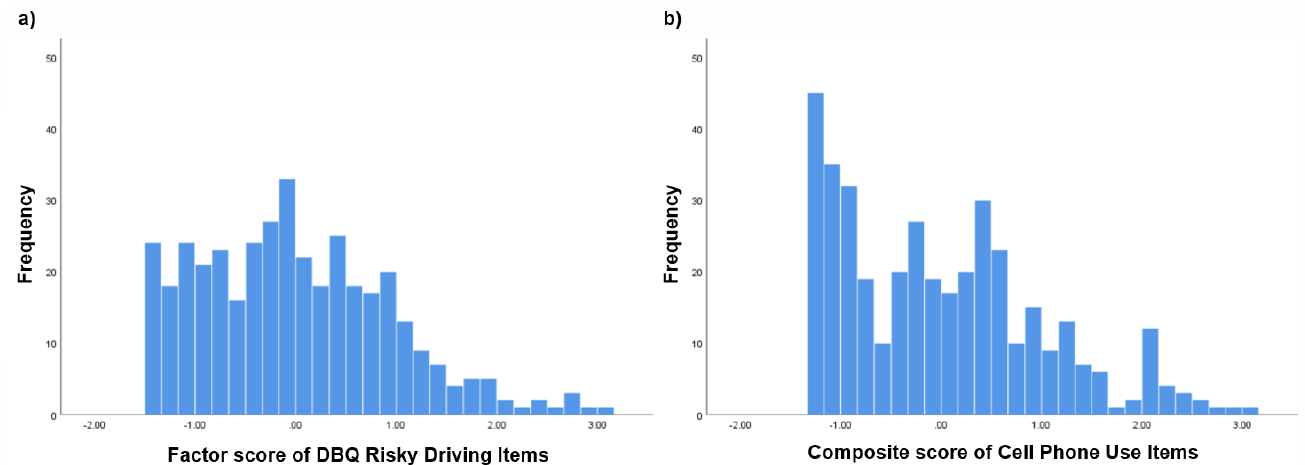
Figure 2. Frequency distribution of responses on ( a ) risky driving items, and ( b ) cell phone use items.